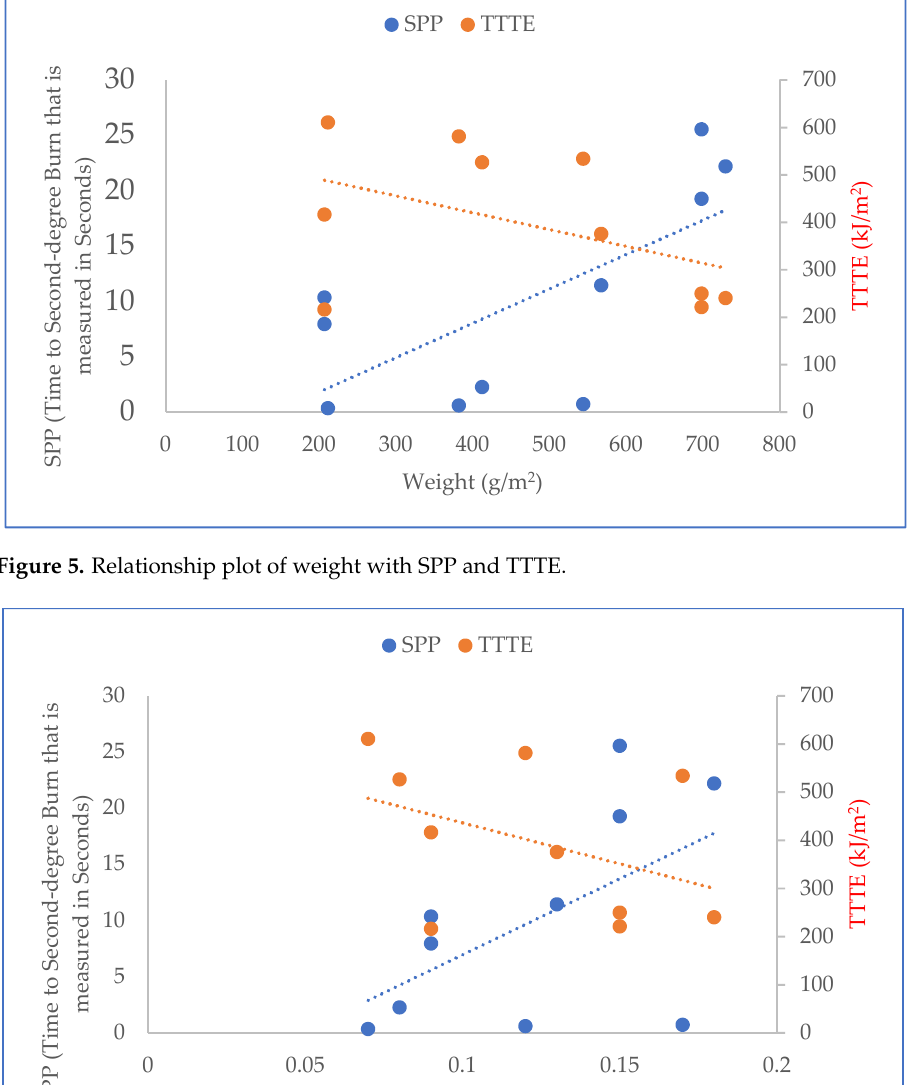
Figure 4. Relationship plot of thickness with SPP and TTTE.